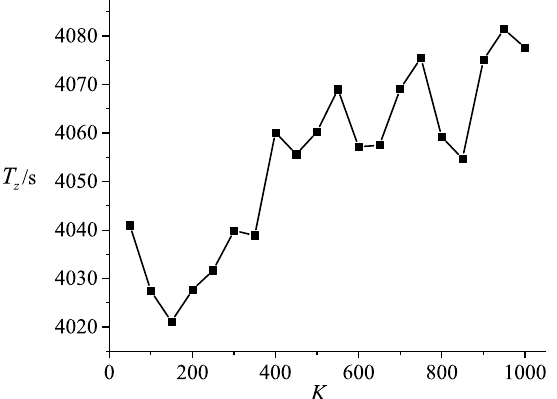
Figure 14. Total time T z versus pheromone amplification coefficient K